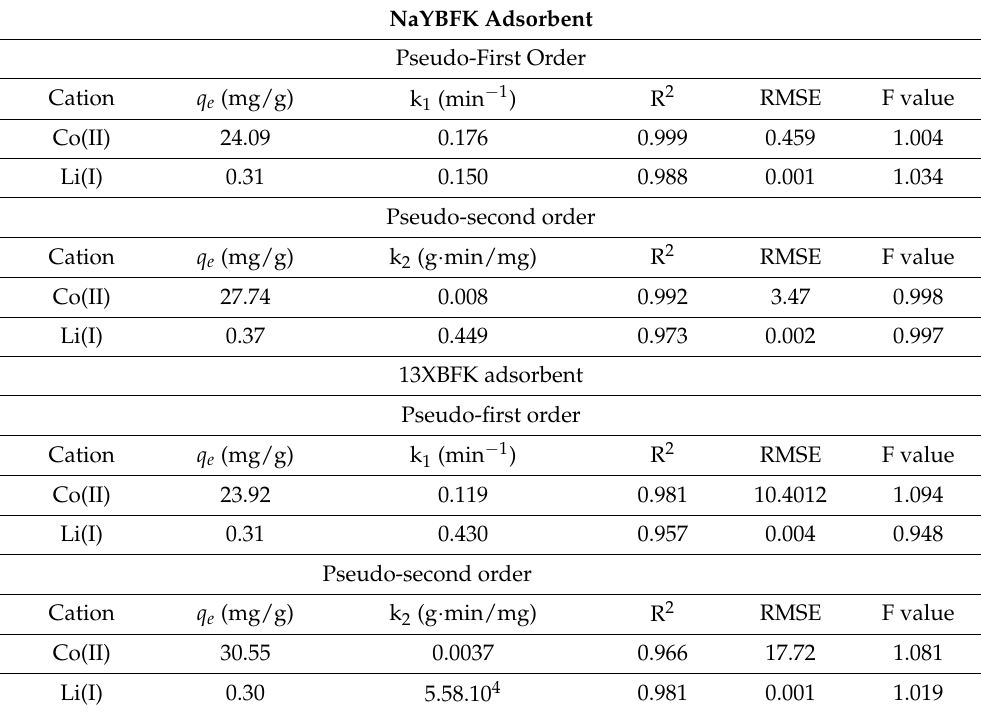
Table 5. Kinetic parameters for Co 2+ and Li + adsorption on NaYBFK and 13XBFK.